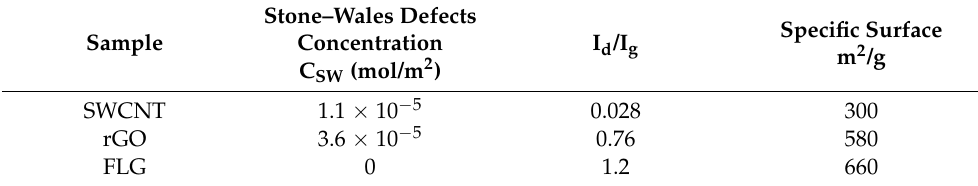
Table 1. Parameters of studied carbon